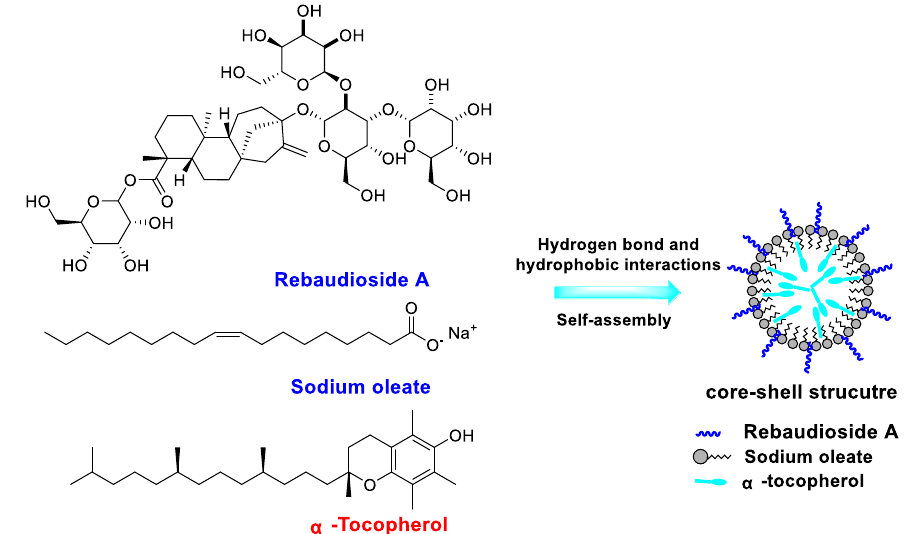
Figure 1. Schematic illustration of the formation of NaOl/RebA complex for the encapsulation of α - TOC.